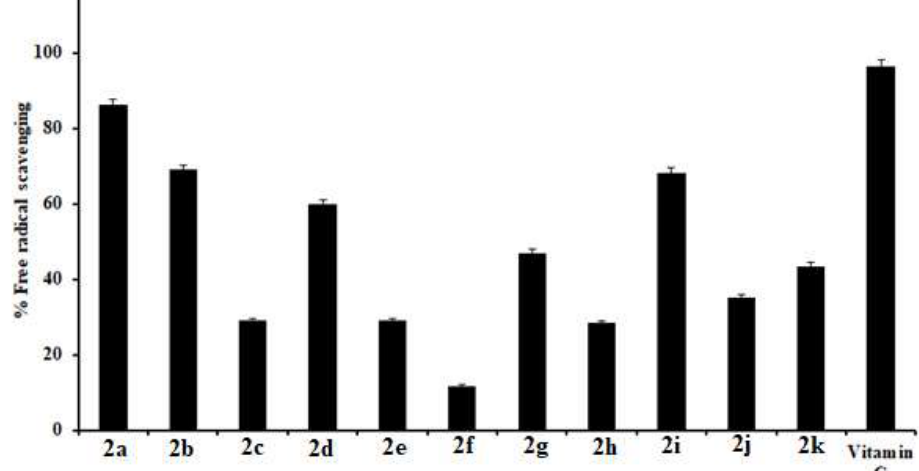
Figure 3. Graphical representation of percentage free radical scavenging activity. Values are given as mean ± SEM. Concentrations of tested compounds = 100 µg/mL.